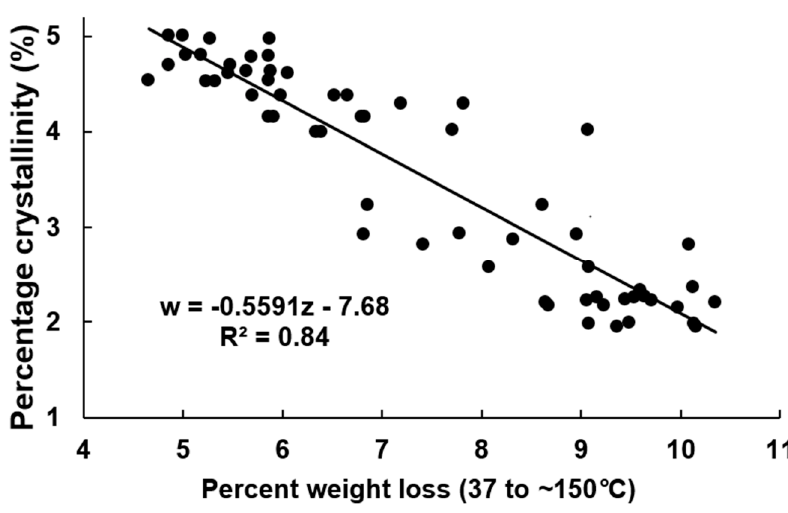
Figure 8. Percent crystallinity as a function of the weight loss percent in the region from 37 to ~150 °C.